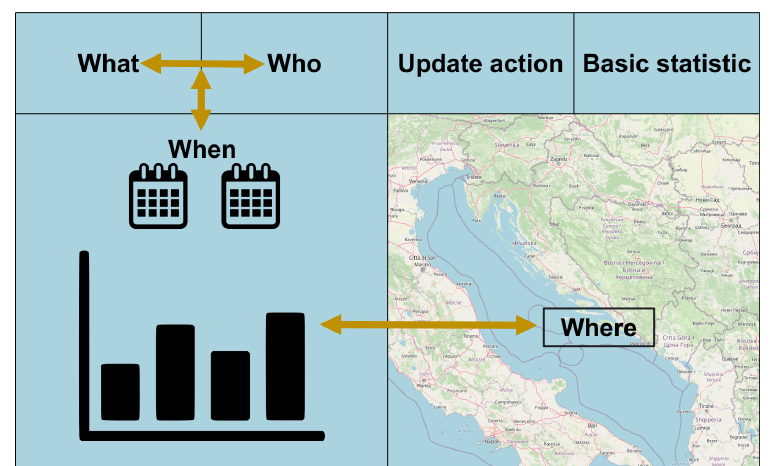
Figure 5. Web interface elements locations diagram.